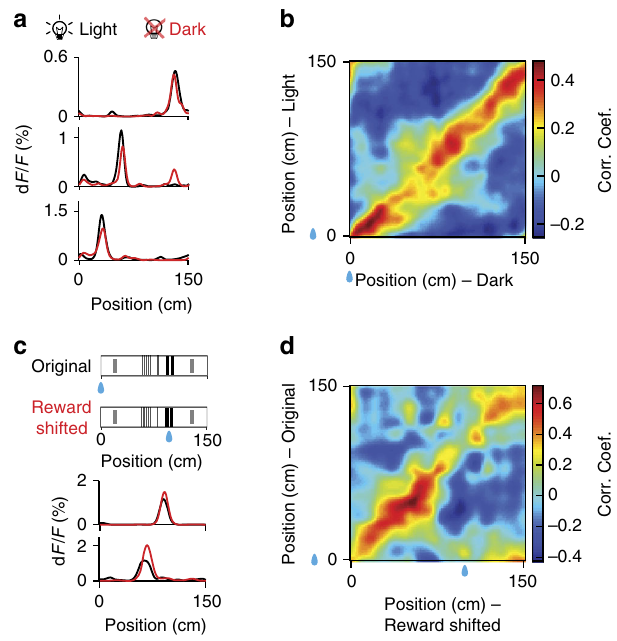
Fig. 5 Correlated RSC population representations of position upon environmental illumination change and reward relocation. a Spatial tuning curves of three example RSC place cells showing preserved place fi elds under light ( black ) and dark ( red ) conditions. b Population vector correlation (Pearson correlation coef fi cient) matrix for all RSC place cells under the light and dark conditions. Blue drops indicate reward locations. c ( top ) Diagram of the reward shift experiment. ( bottom ) Spatial tuning curves of two example RSC place cells showing preserved place fi elds when the reward site was shifted. Black lines , spatial tuning curves before reward shift; red lines , spatial tuning curves after reward shift. Blue drops indicate reward locations. d Population vector correlation (Pearson correlation coef fi cient) matrix for all RSC place cells under original and reward shifted conditions. Blue drops indicate reward locations. (Data from Thy1